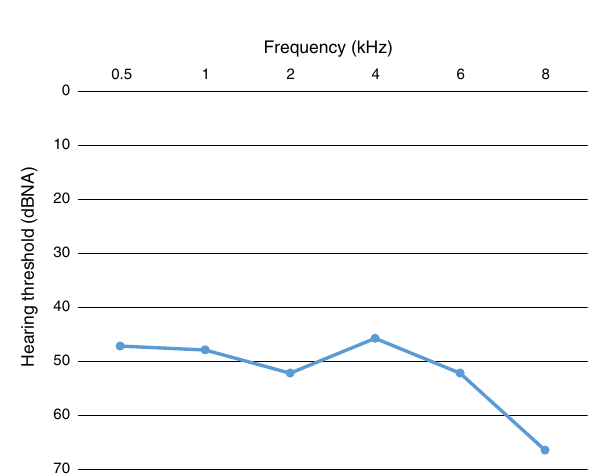
moderate correlation of quadritonal and tritonal 2 averages with total scores of HHIA and its social domain (Table